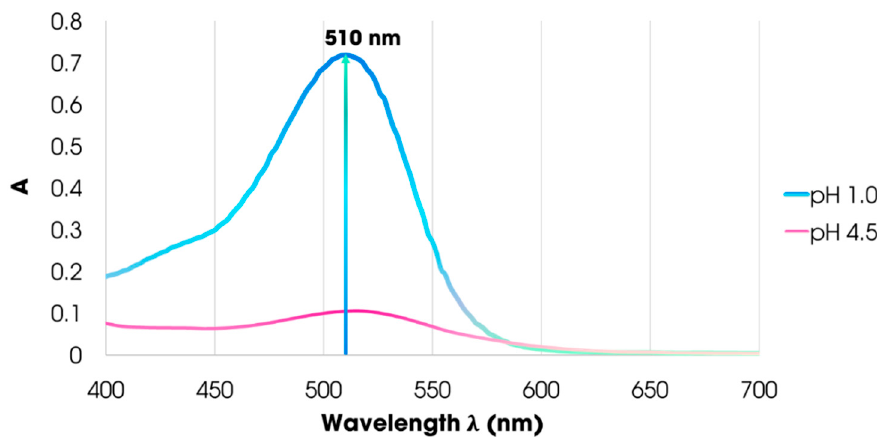
Figure 1. Maximum absorption wavelength in different pH environments.